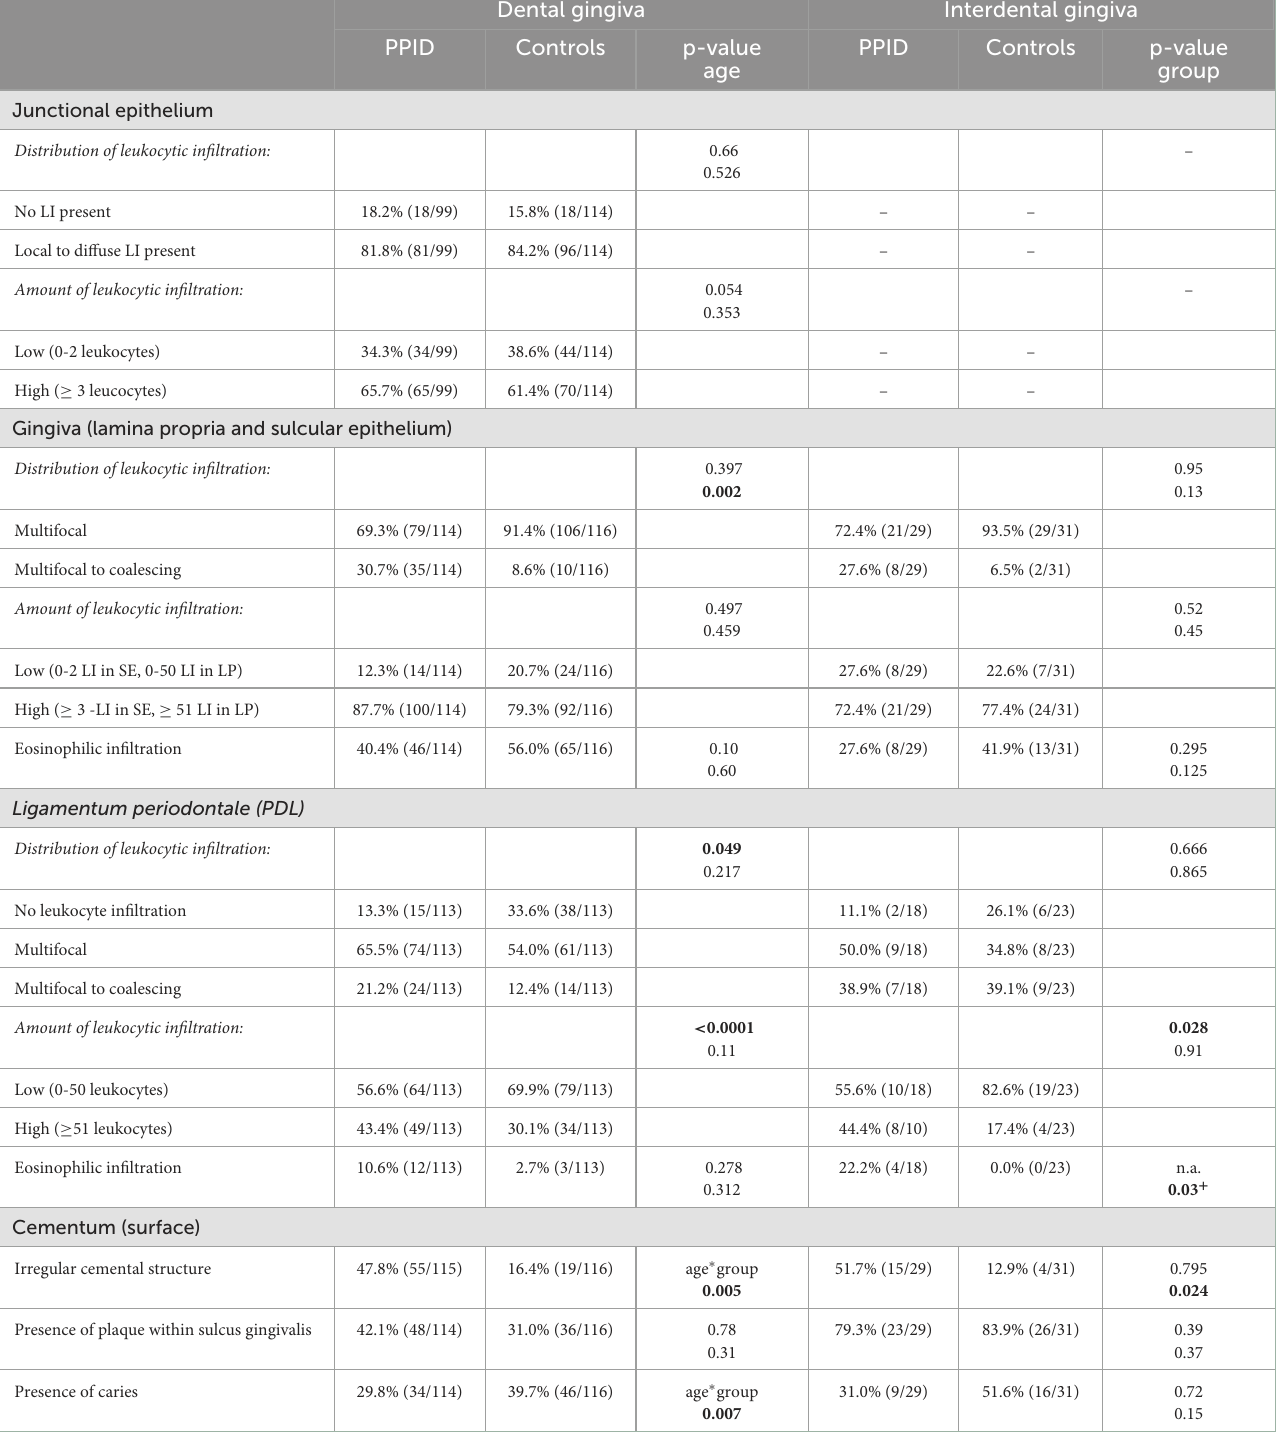
TABLE 3 Characteristics of the histology of the equine periodontium in PPID and control horses. Dental gingiva Interdental gingiva PPID Controls p-value